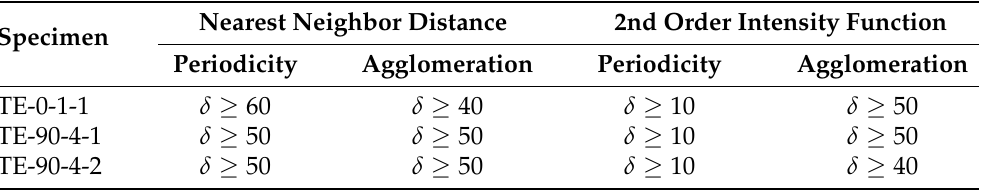
Table 3. Summary of minimum recommended size δ according to the adopted criteria.